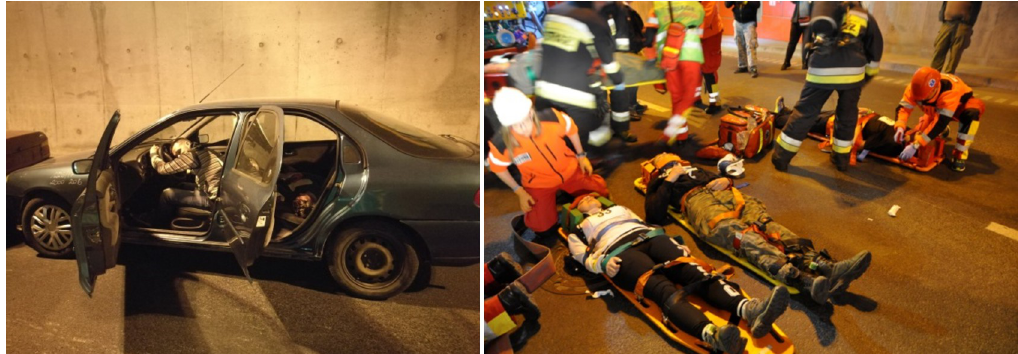
Fig 5. Experiment 3 in Gda ń sk, dedicated to fire brigade and rescue service